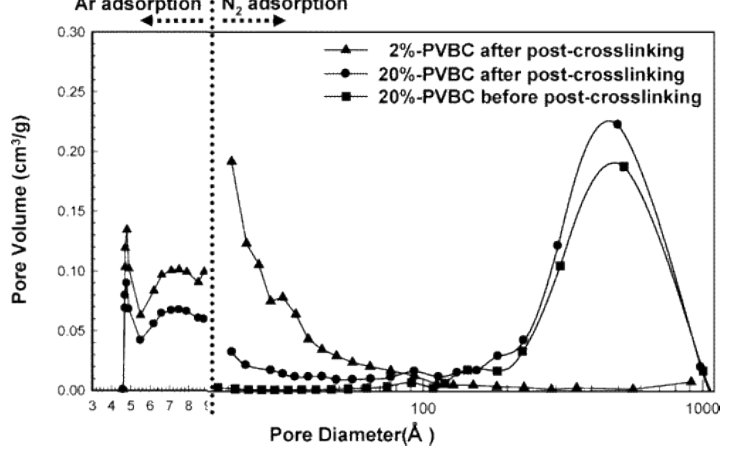
Figure 2. Pore size distribution of divinylbenzene/vinylbenzyl chloride polymers containing 2 and 20 mol % DVB. Reprinted with permission from reference [37]. Copyright 2006 American Chemical Society (Washington, United States of America).